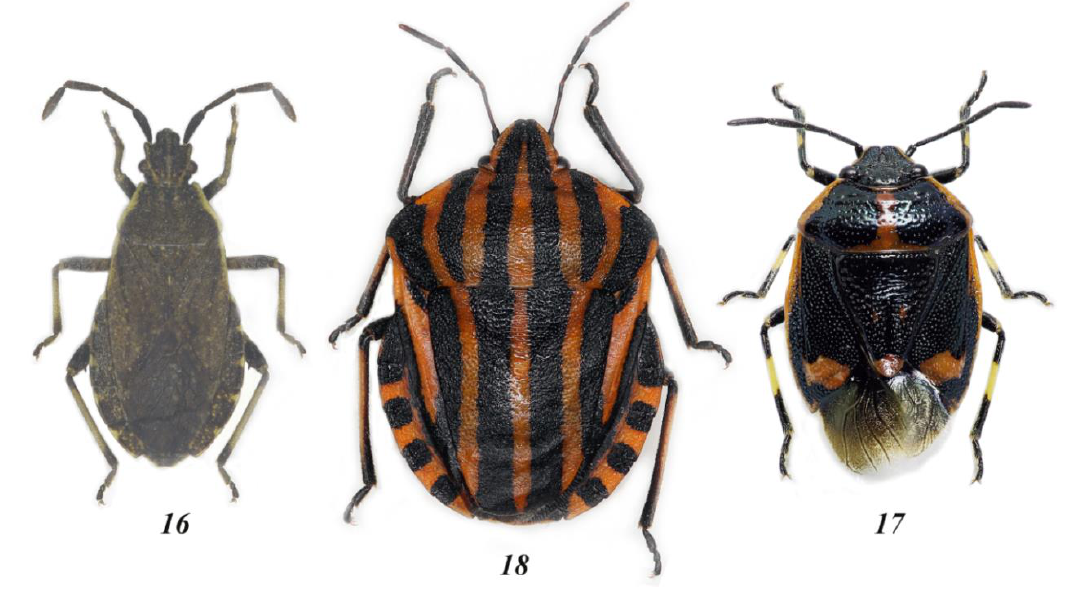
Рис. 16-18. 16. Nemocoris falleni R.F. Sahlb., ♀ (ориг.); 17. Eurydema oleracea L., ♂ (ориг.); 18. Graphosoma lineatum L., ♀